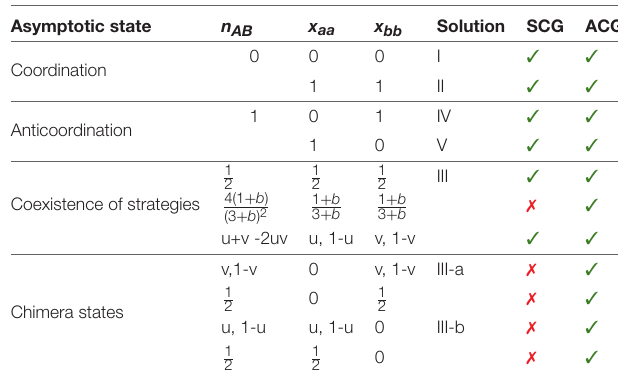
TABLE 3 | Asymptotic states and associated values of x aa , x bb , and n AB .